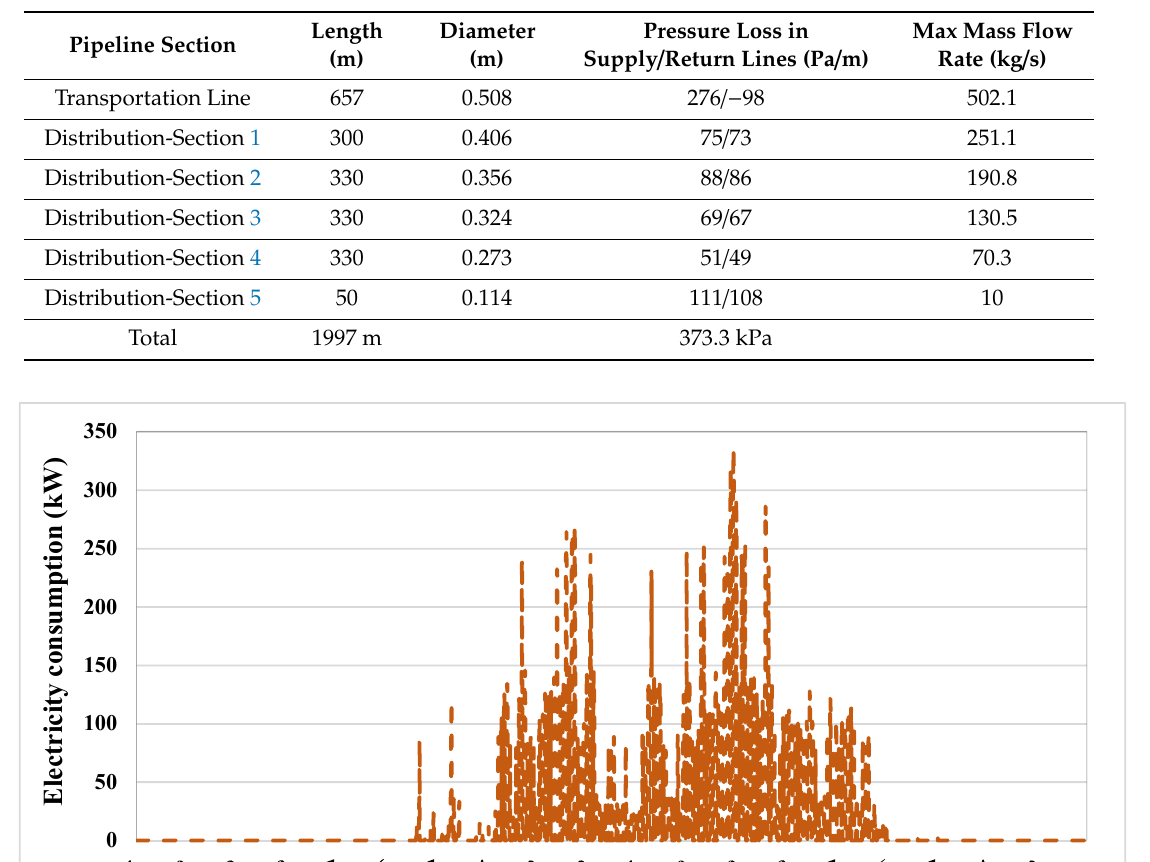
Table 4. The calculated dimensions of the pipeline of the district cooling system.